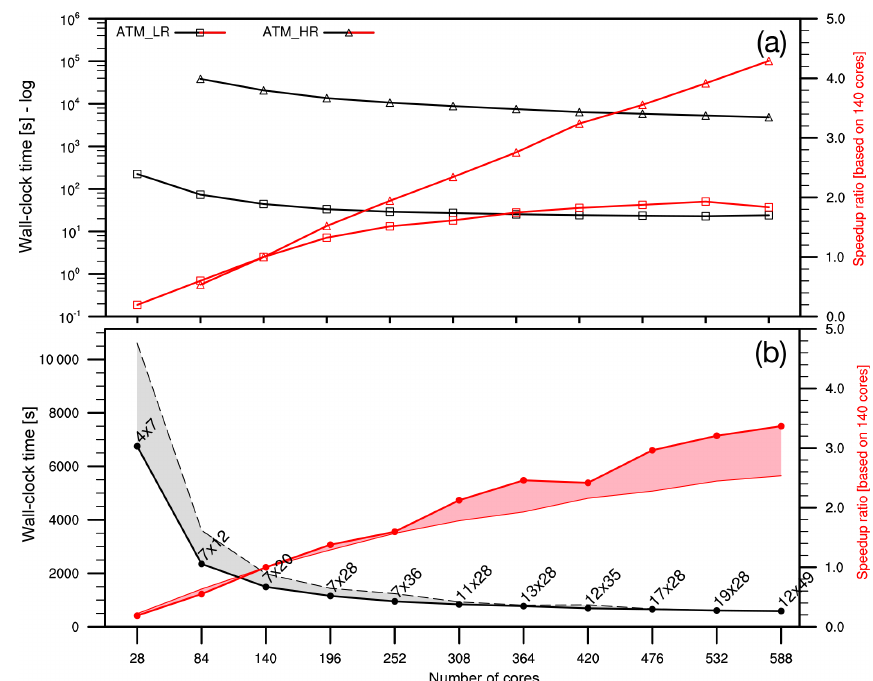
Figure 9. Benchmark results of stand-alone (a) atmosphere (ATM; both LR and HR) and (b) ocean (OCN) models. Note that timing results of the atmosphere model are in log axes to show both LR and HR cases in the same figure. The black lines represent measured wall-clock times in seconds and red lines show speedup. The envelope represents the timing and speedup results that are done using the same number of cores but different two-dimensional decomposition configuration. The best two-dimensional decomposition parameters are also shown in the timing results for the ocean model